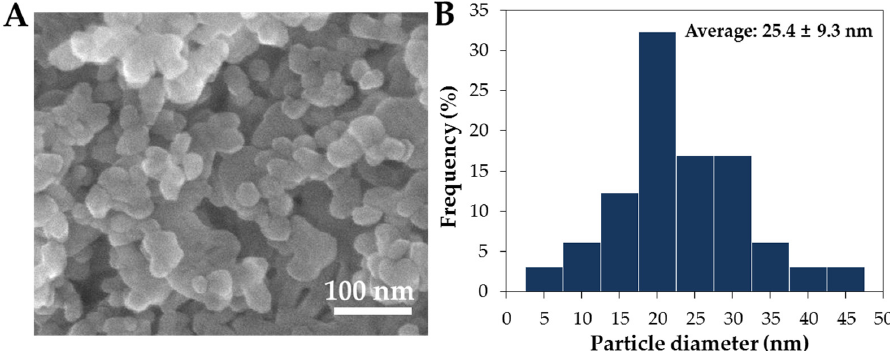
Figure 1. ( A ) Scanning electron microscopic (SEM) images and ( B ) size distribution of ZnO NPs. Particle size distribution was determined by randomly selecting 200 particles from the SEM images.